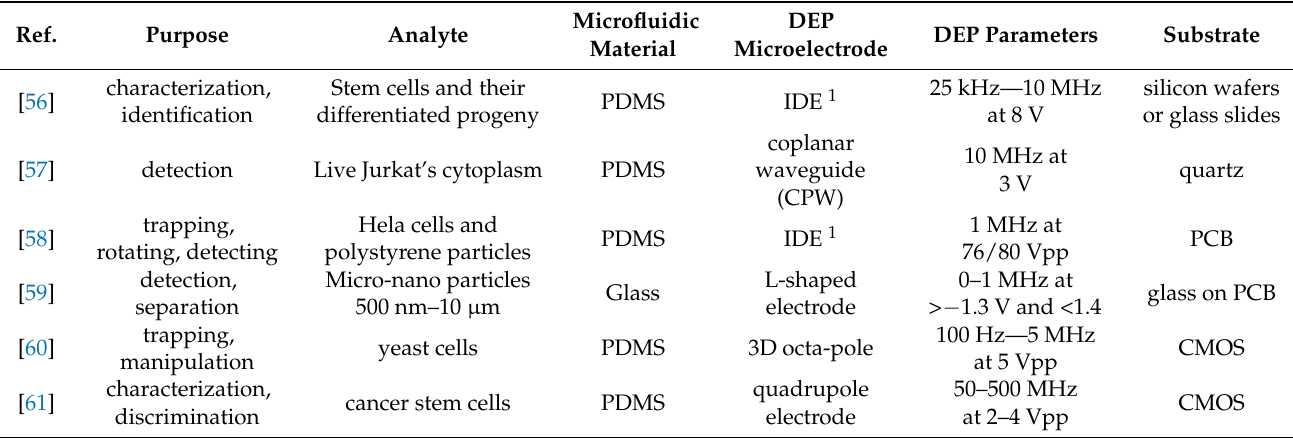
Table 1. Various DEP-on-a-chip platform examples for cell analysis